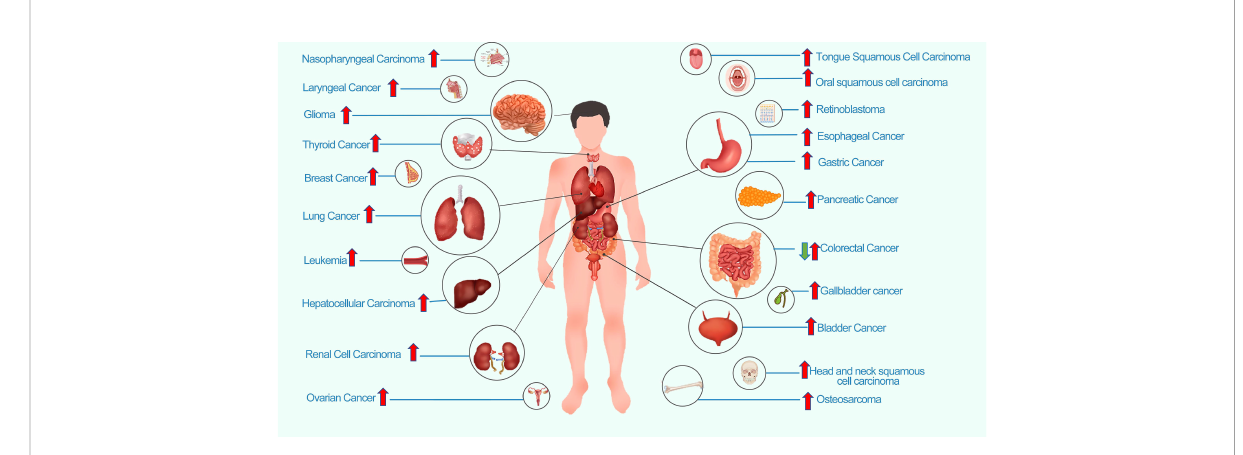
FIGURE 2 Dysregulation of LINC00152 expression in human